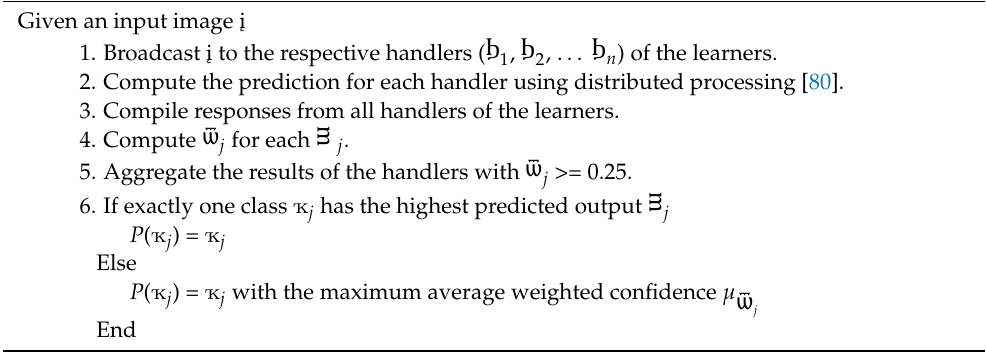
Algorithm 2: Weighted Majority Voting Ensemble Deep